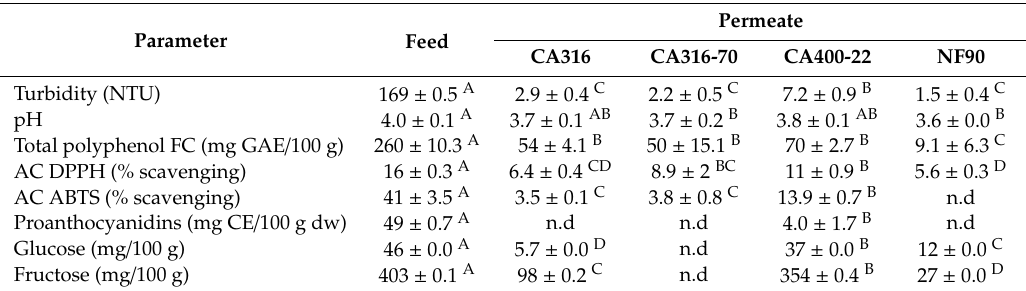
Table 7. Physico-chemical characteristics of feed and permeate samples obtained in the NF of grape pomace